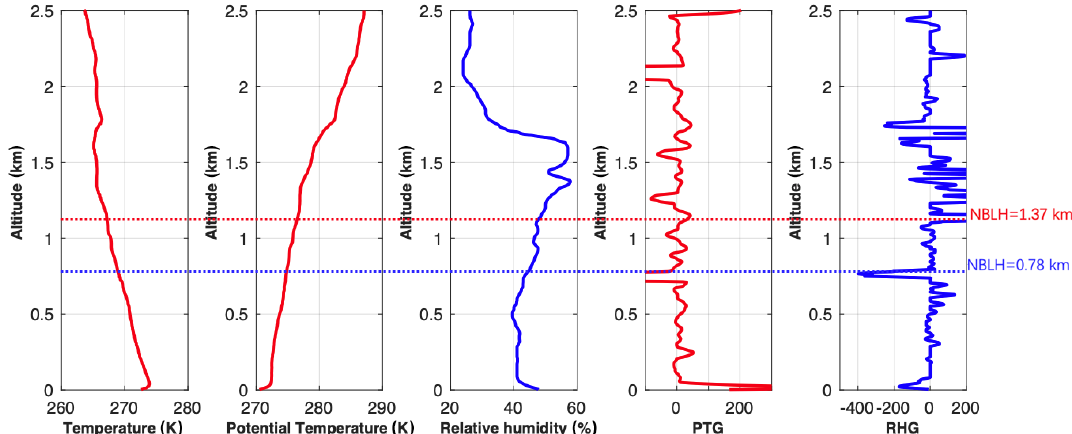
Figure 8. Planetary boundary layer height estimates using radiosonde. Profiles include temperature, potential temperature, relative humidity, potential temperature gradient (PTG), and relative humidity gradient (RHG). Estimated NBLH by PTG (red) and RHG (blue) are shown by dashed horizontal lines.